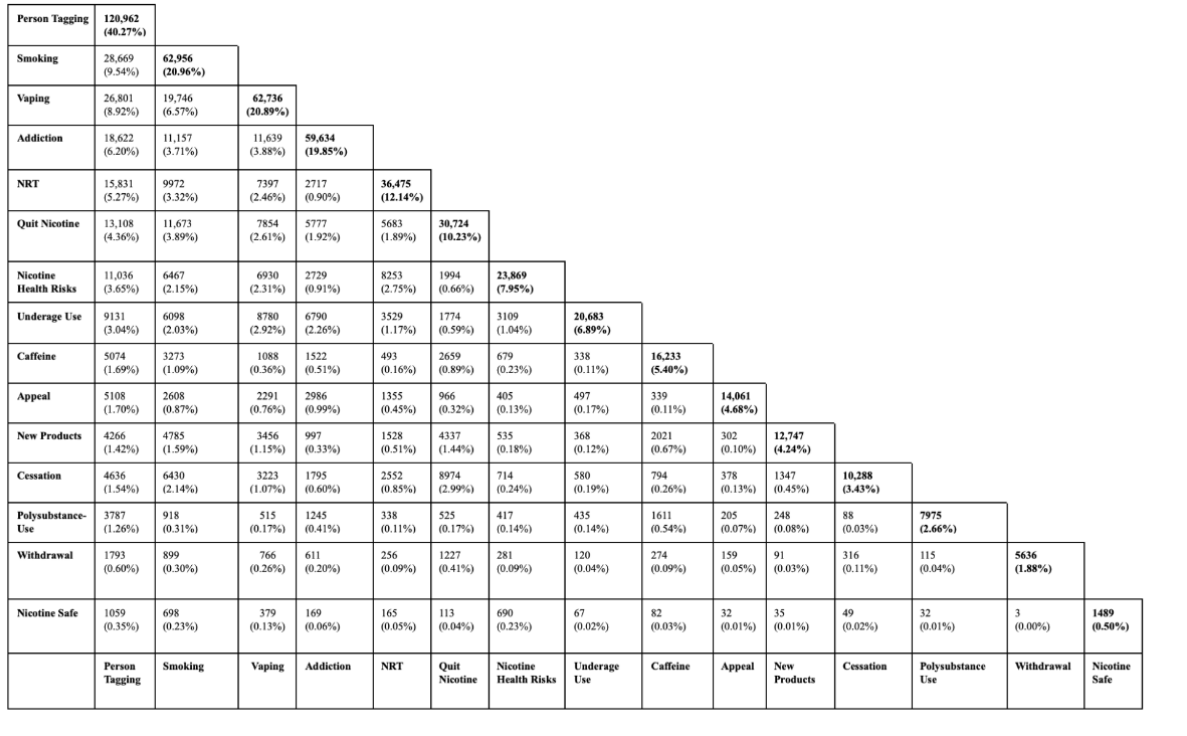
Figure 1. Prevalence of topics from nonbot corpus. NRT: nicotine replacement